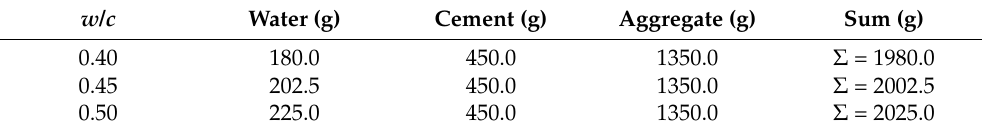
Table 2. Amount of water, cement, and aggregate used, depending on the w / c ratio. w / c Water